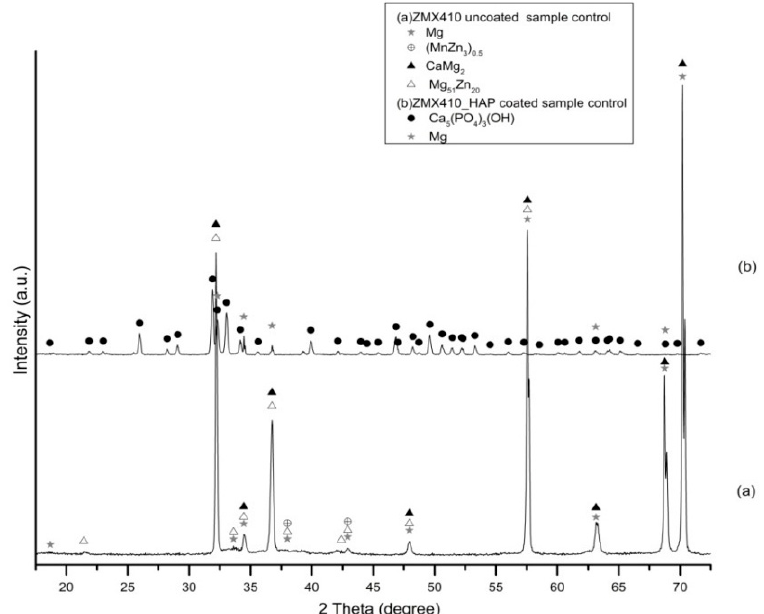
Figure 6. Patterns of uncoated ( a ) and hydroxyapatite (HAP)-coated ( b ) ZMX410 alloy (bullets indicate the peaks corresponding to diffraction angles of the main phases) .